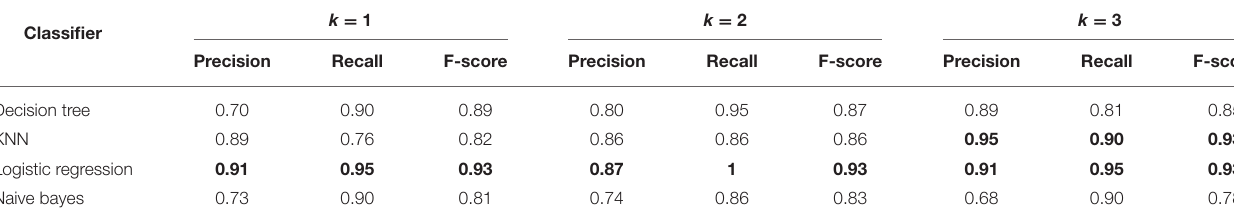
TABLE 10 | Precision, Recall, and F-scores for the prediction accuracy of the Human-aware Intervention learned models.